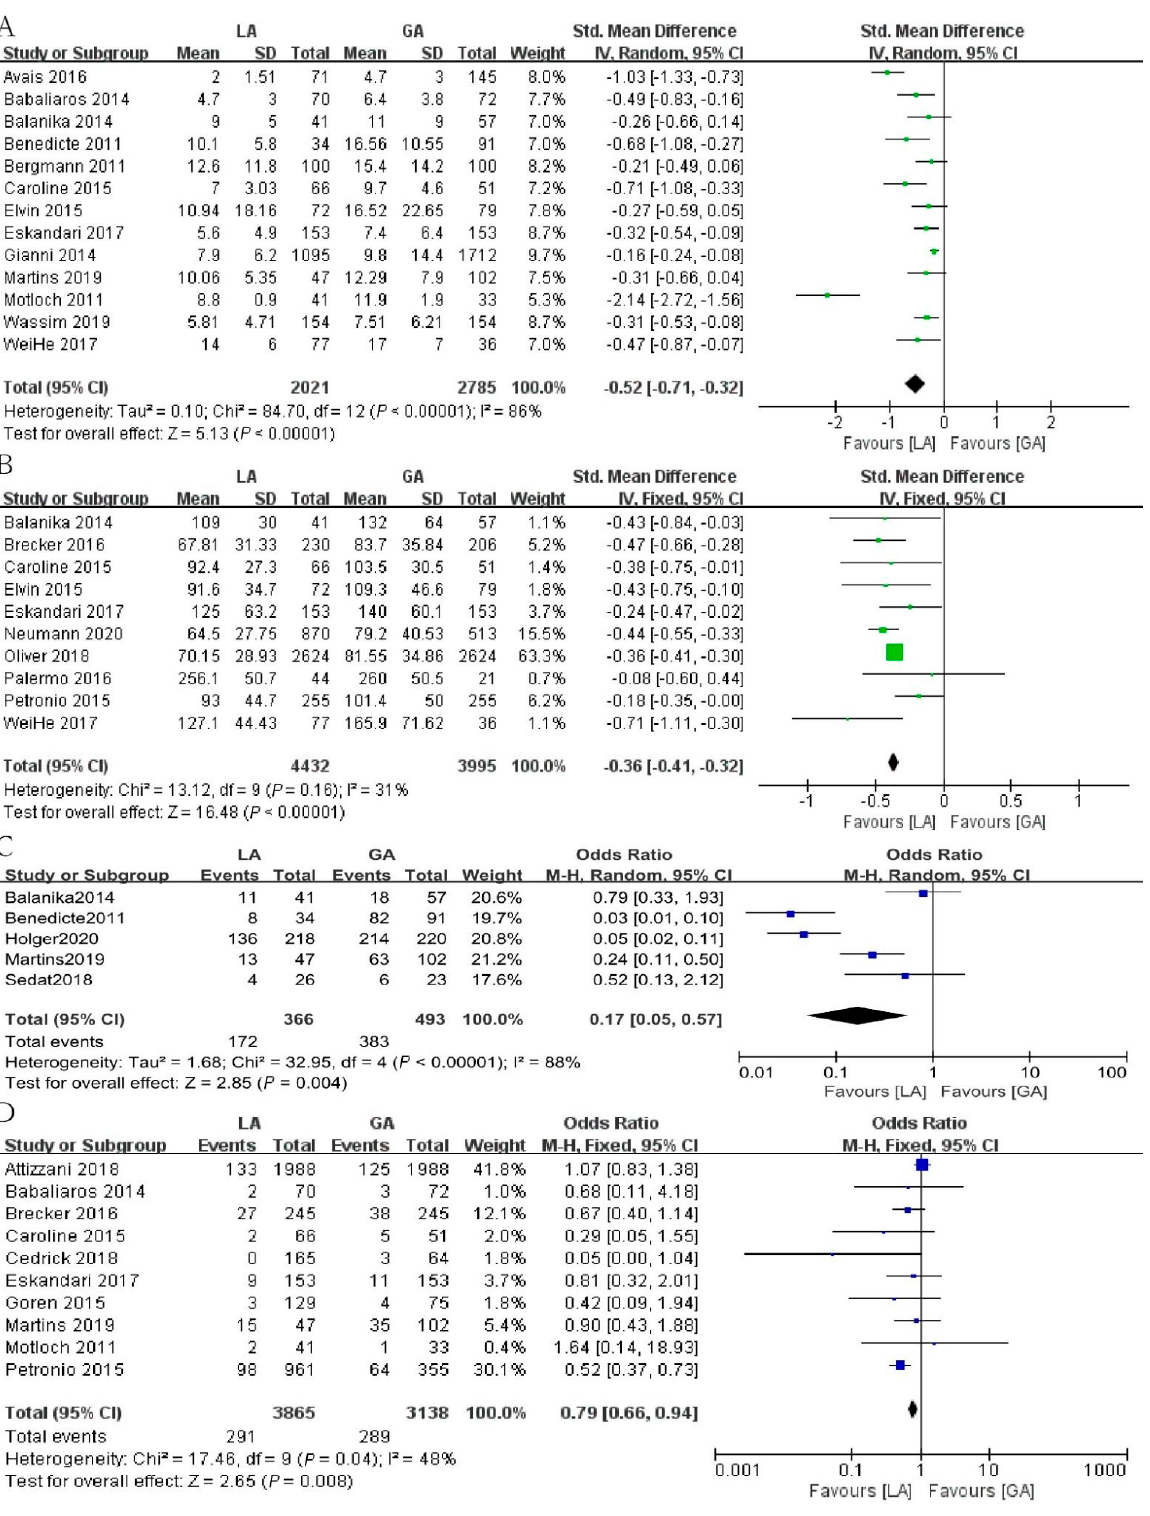
Figure 3. Forest plot of ( A ) length of stay, ( B ) the procedural time, ( C ) use of cardiovascular drugs, ( D ) the incidence of major bleeding. Green symbols: continuous data; blue symbols: dichotomous data; black symbols: other type data.